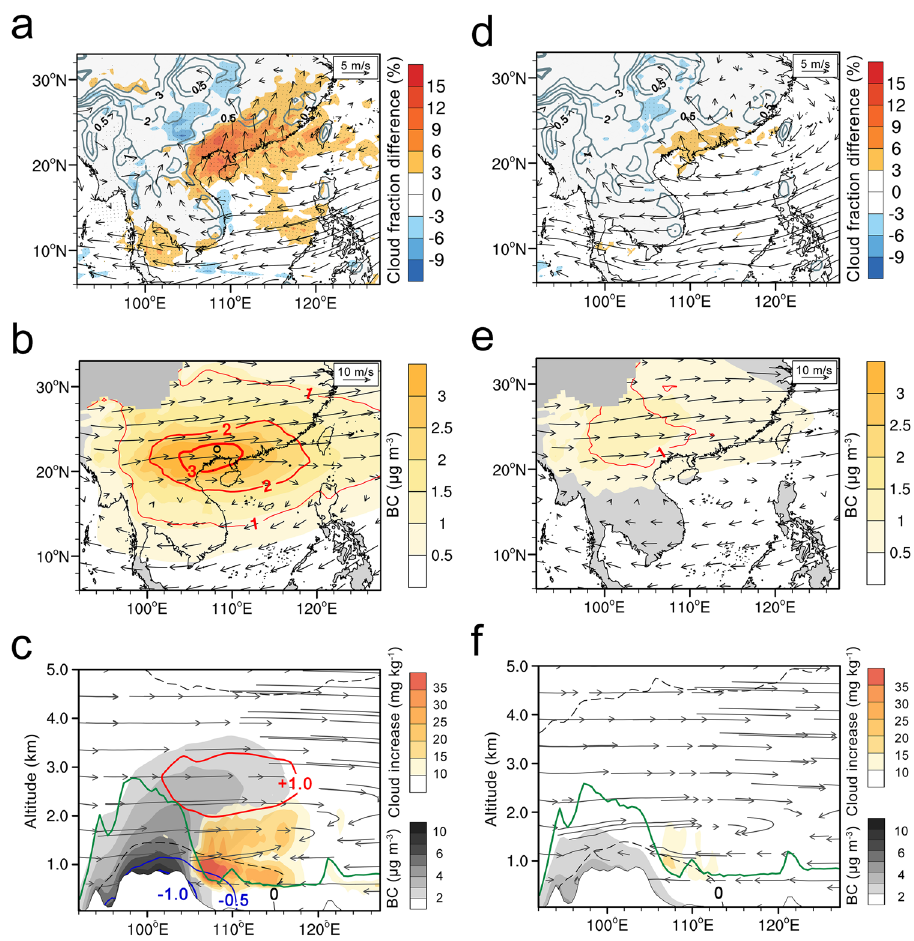
Fig. 3 Simulated low-cloud enhancement by semi-direct effect of biomass-burning aerosols in subtropical southeastern Asia. a Monthly averaged difference of low cloud fraction plotted with winds at an altitude of 1 km in March of high aerosol optical depth (AOD) years. b Spatial patterns of black carbon (BC) concentrations and aerosol-induced atmospheric heating rate at the altitude of 3 km (red isolines with the unit of K day − 1 ) in March of high- AOD years. c Vertical cross-section of BC concentration, cloud enhancement and air temperature difference (red contours for heating and blue contours for dimming, unit: K) along the coastal region (17°N – 23°N) for the runs with ARI effect on/off in March of high-AOD years (2004, 2007, 2010, and 2014). d – f , Same as a – c but for low-AOD years (2001, 2003, 2005, 2011). The results are calculated from the difference between simulations with and without considering aerosol – radiation interaction (EXP_ARI and EXP_exAR). Note: Gray isolines in ( a ) and ( d ) show topography (unit: km) and black dots mark the grids passing a T -test. Green lines in ( c ) and ( f ) show the boundary layer height at 6:00 UTC. The black circle in ( b ) shows the location of